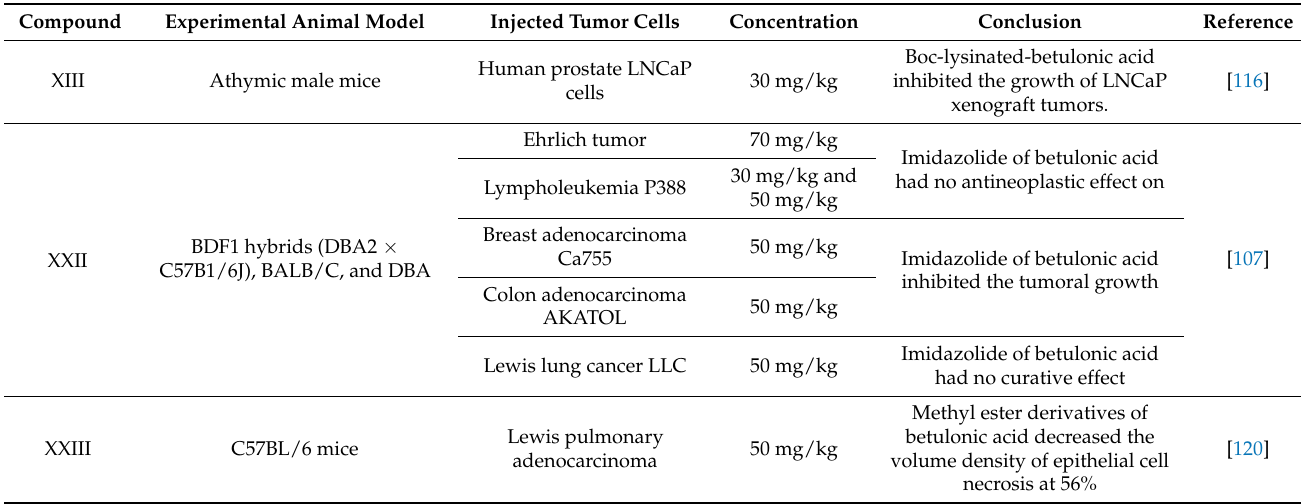
Table 3. In vivo studies of betulonic acid